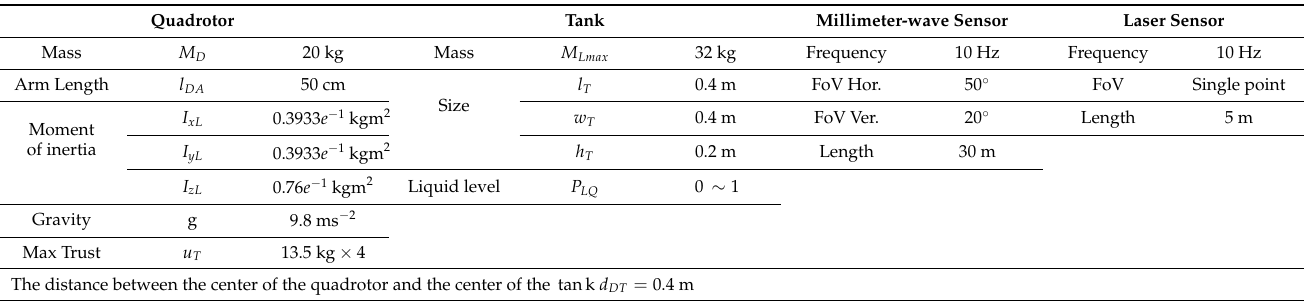
Table 2. Parameters of the tank-carrying quadrotor UAV